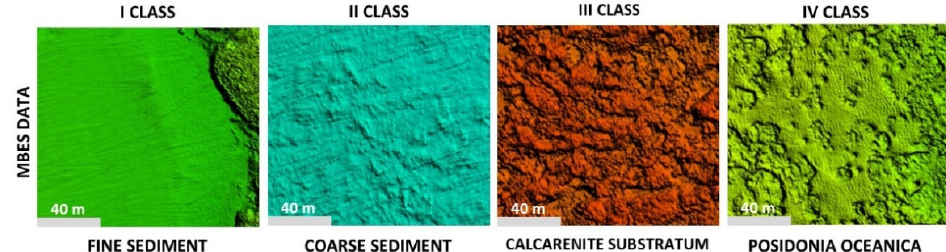
Figure 4. Correlation between the Multibeam data (MBES) and the more representative lithological, grain size, and biological attributes recognized in the study area.